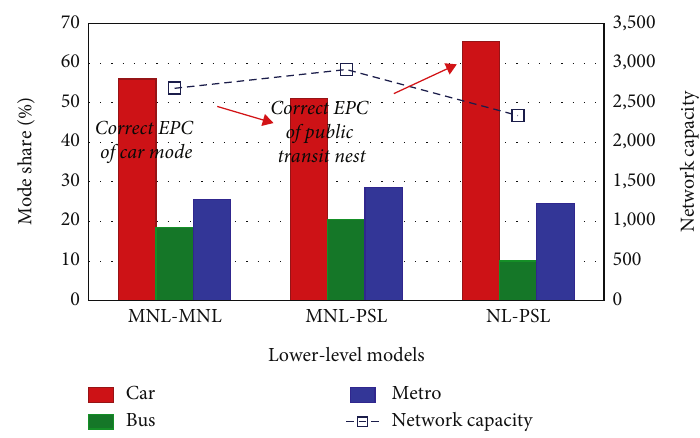
Figure 12: Results of network capacity with di ff erent lower-level